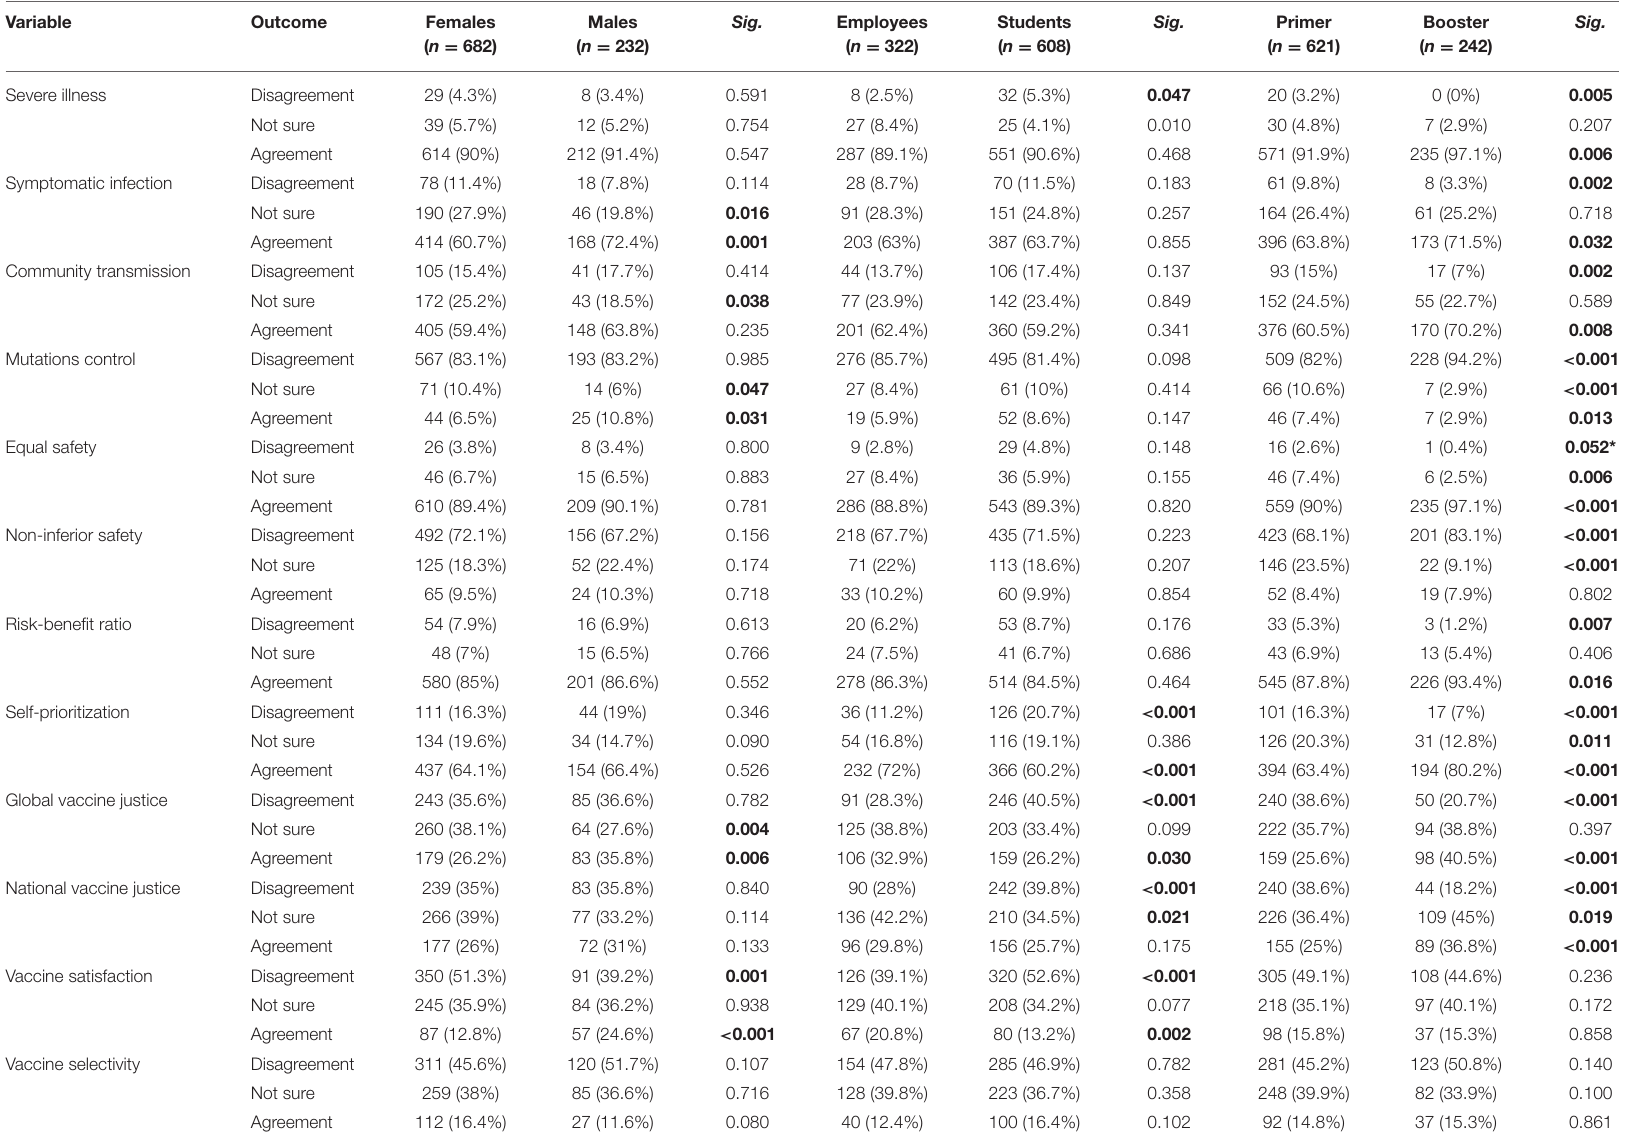
TABLE 5 | Psychosocial drivers of German university students and employees participating in the COVID-19 Vaccine Booster Hesitancy (VBH) Survey stratified by gender, employment status, and number of doses, december 2021 ( n = 930).